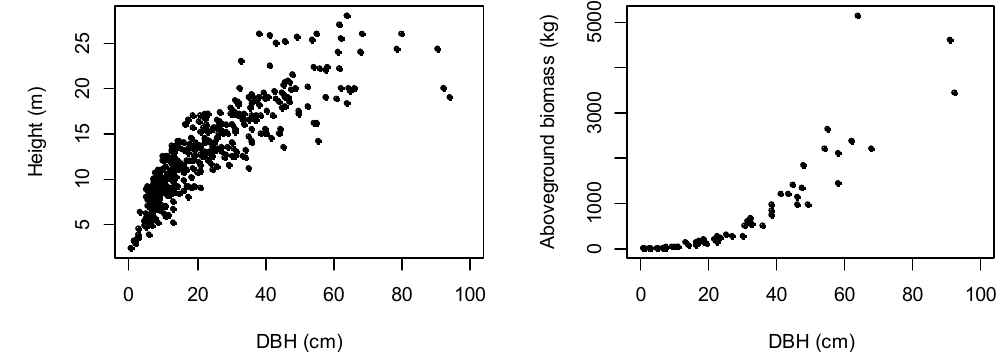
Figure 2. Variation of height and aboveground biomass (AGB) according to tree diameter.